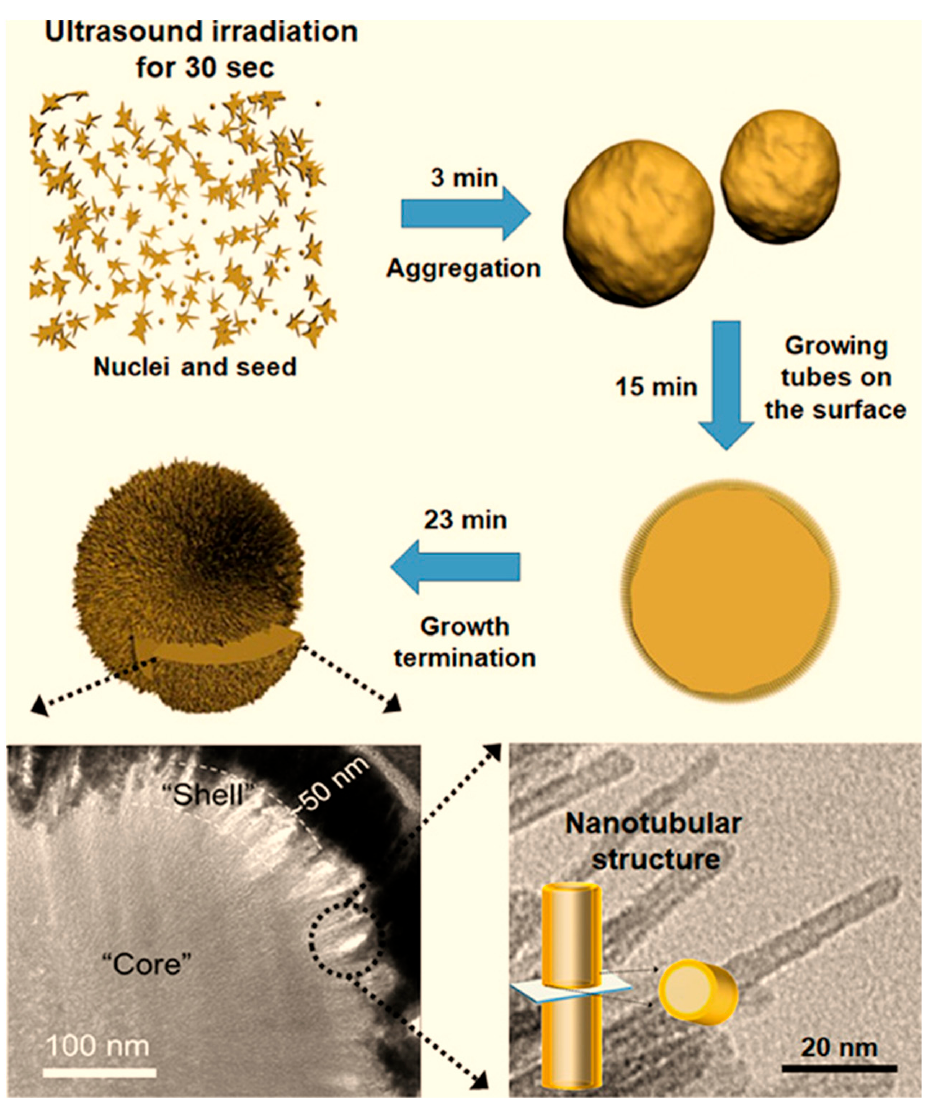
Figure 17. Formation mechanism and TEM images of urchin-shaped iron oxide nanostructures (Fe 2 O 3 ) produced through ultrasound irradiation [160].